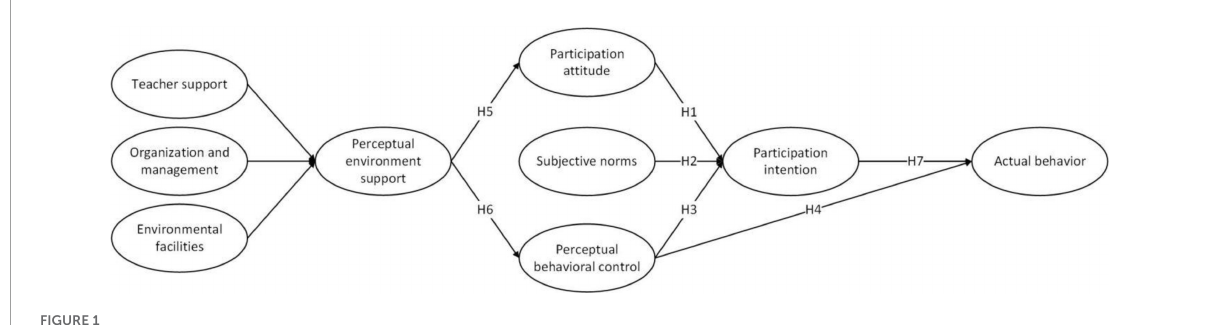
FIGURE1 Research